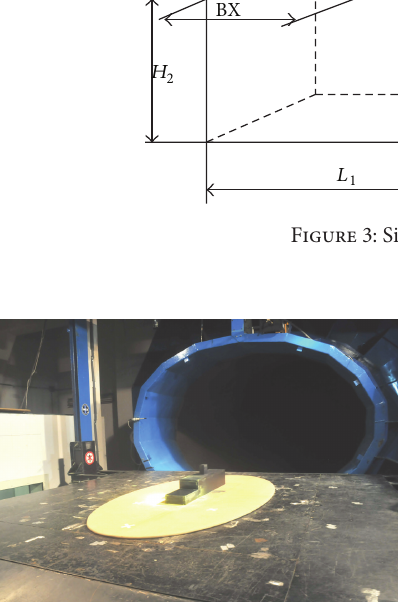
Figure 4: SFS model in the test section of the wind tunnel.